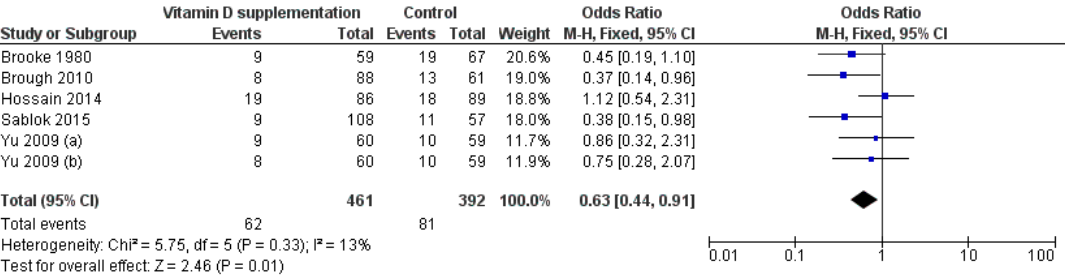
Figure 6. Forest plot of the effect of vitamin D intervention on the risk of small for gestational age, based on the fixed-effects model. Yu 2009 ( a ): Vit D2 (800 IU/day); Yu 2009 ( b ): Vit D2 (single dose of 200000 IU).